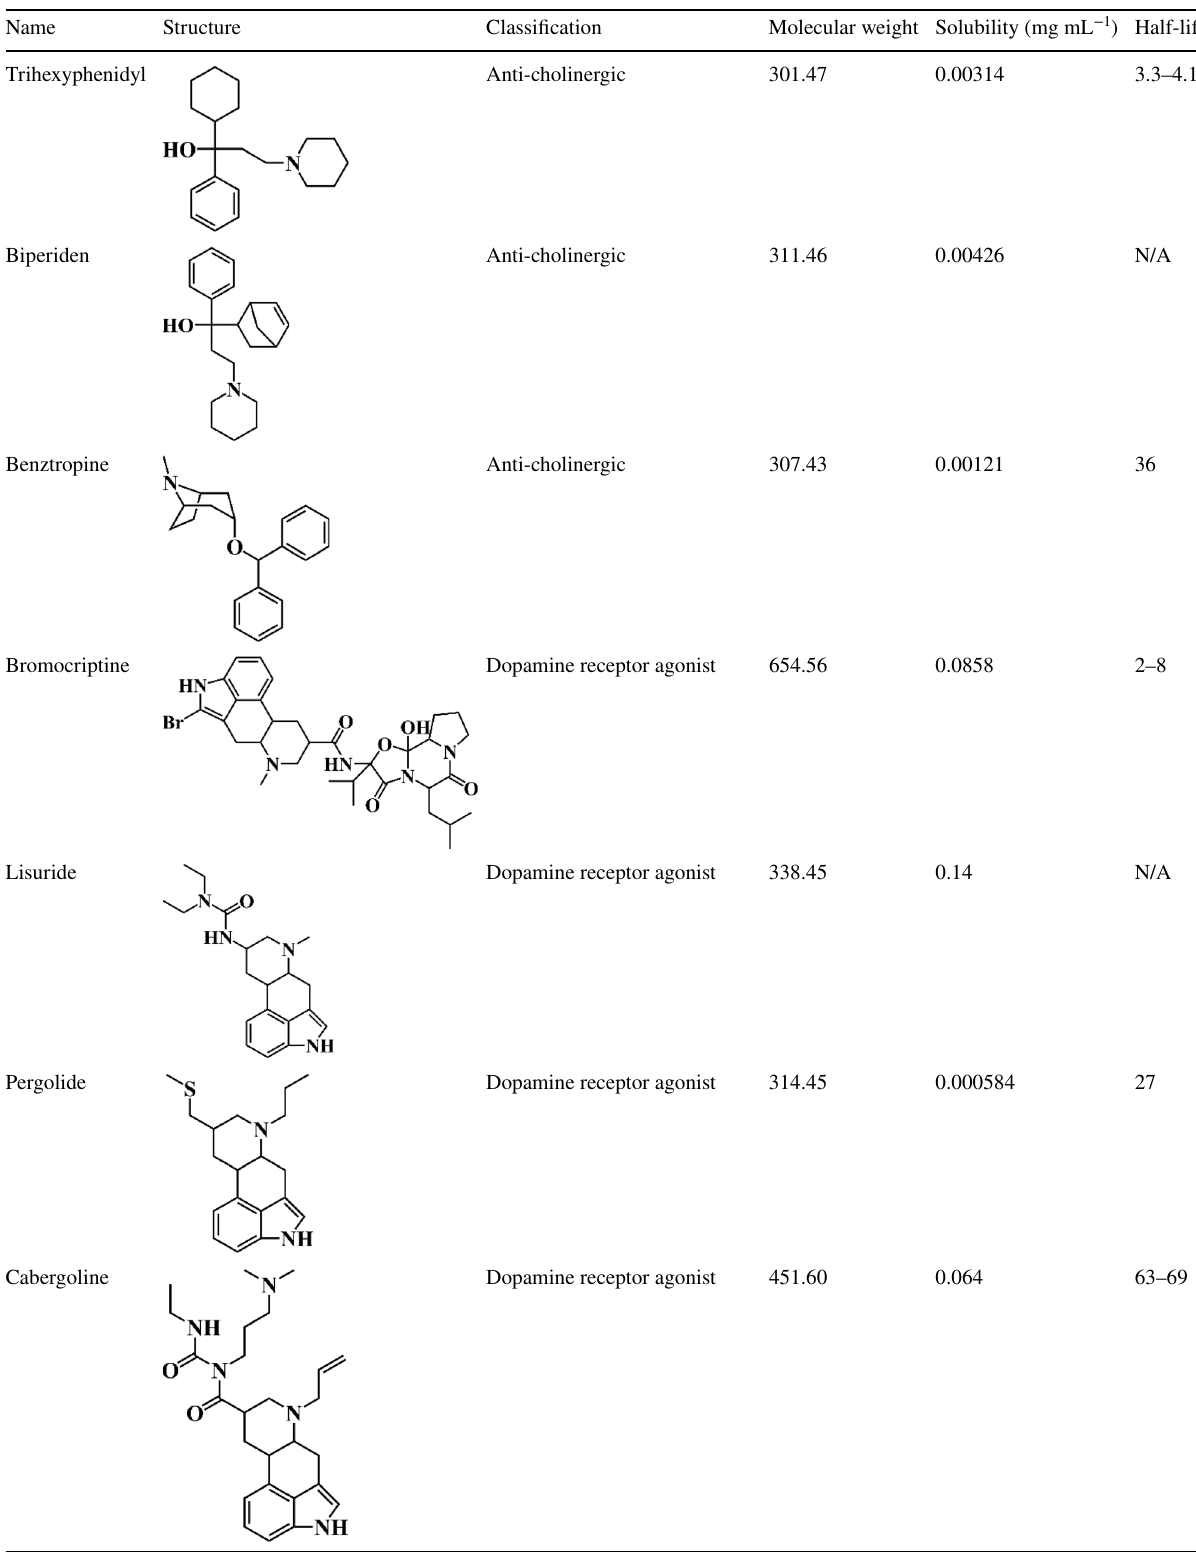
Table 1 List of Anti-Parkinsonian drugs, all with adverse effects on non-motor functions (data obtained from the Drugbank